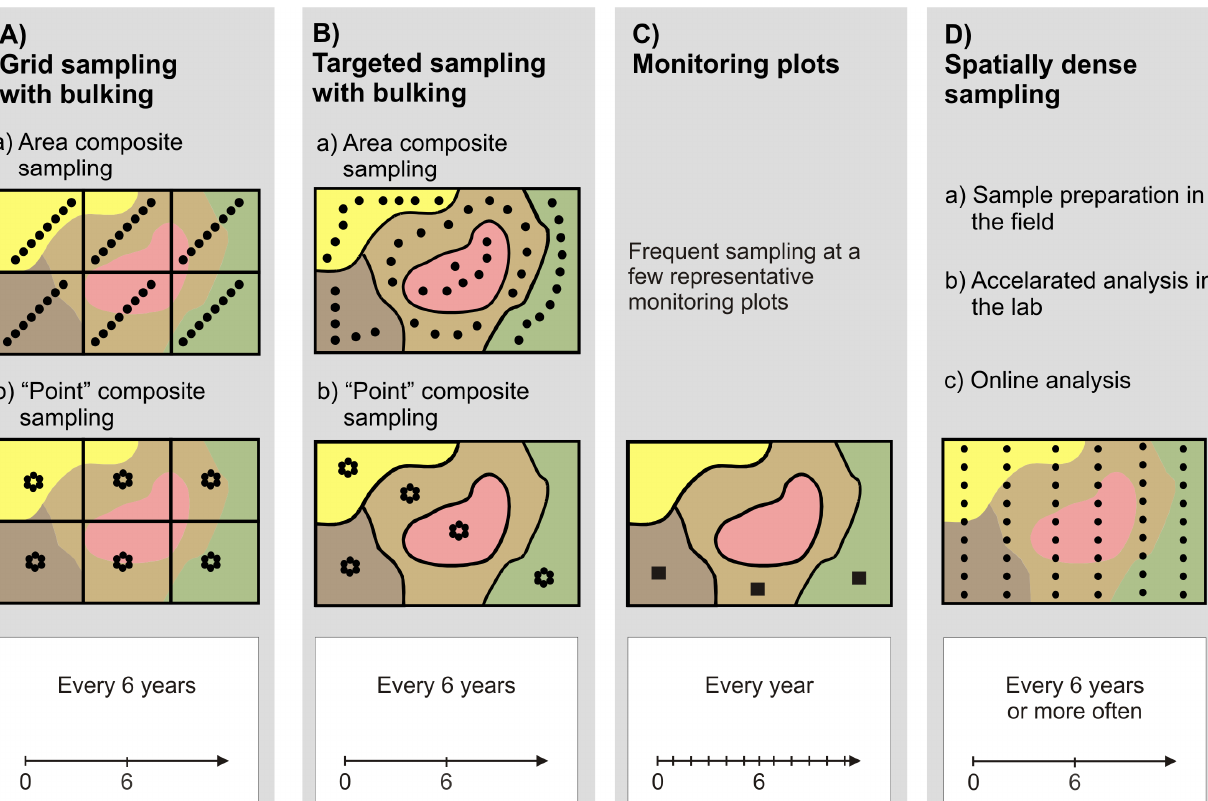
Figure 1. Sketch of standard and alternative sampling strategies for soil pH mapping (details are given in the